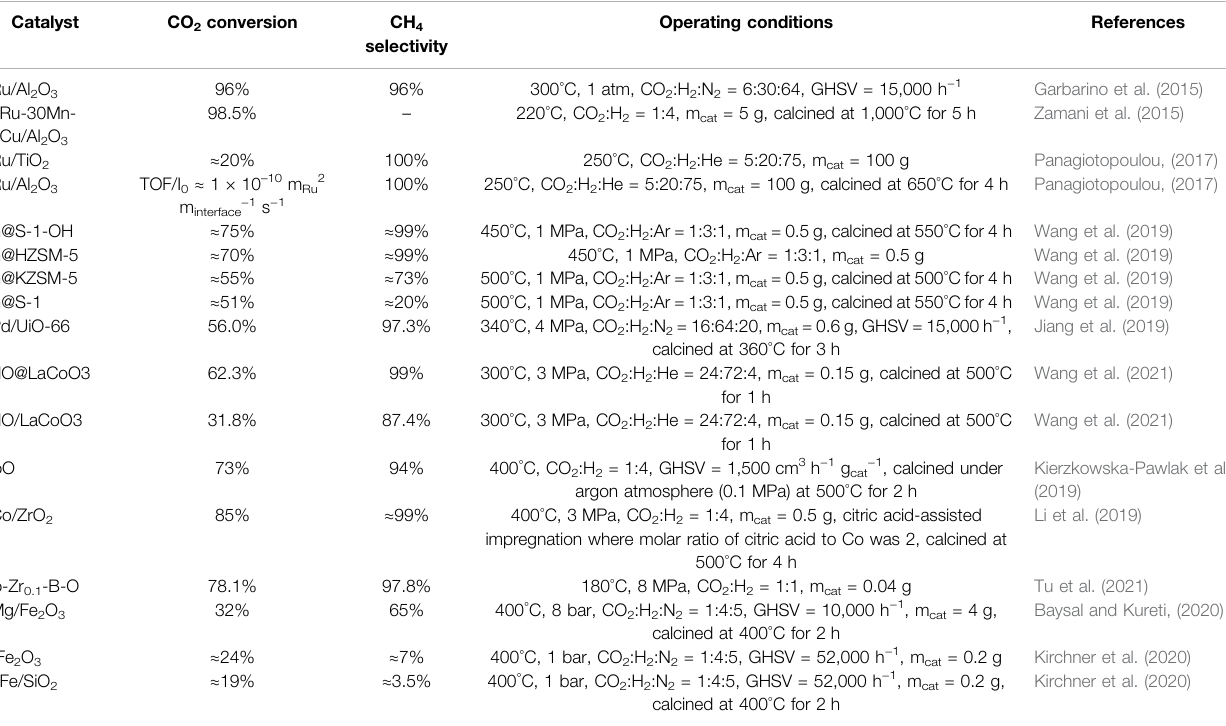
TABLE 2 | Performance comparison of different transition- and noble-metal-based catalysts for CO 2 methanation.